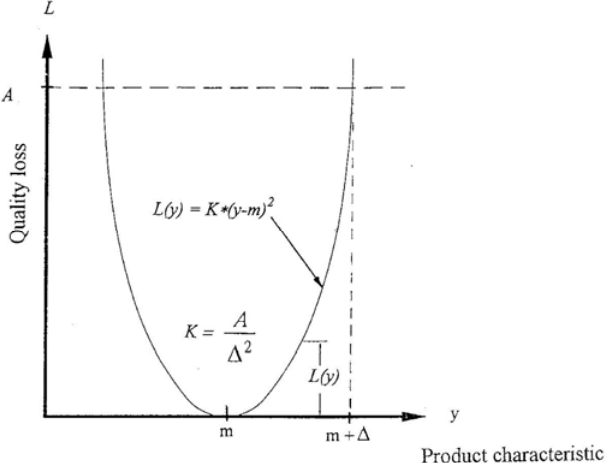
Figure 1 Taguchi’s loss function.